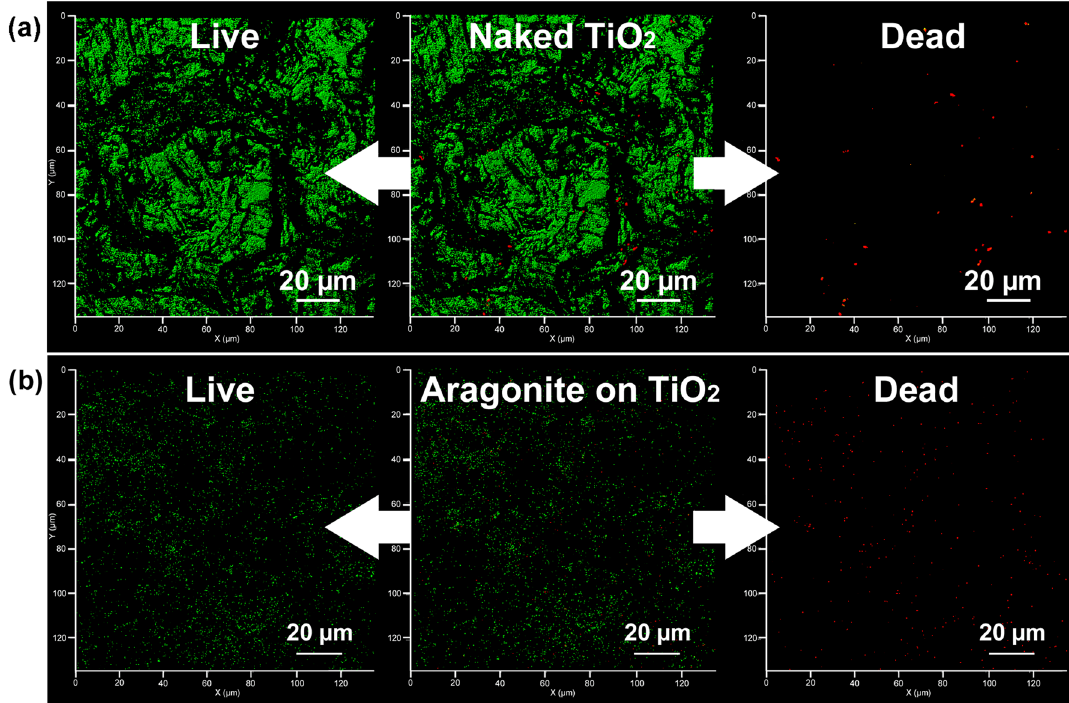
Figure 4. Confocal microscopy image of stained E. coli on an unmodified TiO 2 ceramic surface ( a ) and an aragonite-modified TiO 2 ceramic surface ( b ). The L/D composite image is shown in the center, and the distribution of live and dead bacteria is shown on the left and right,